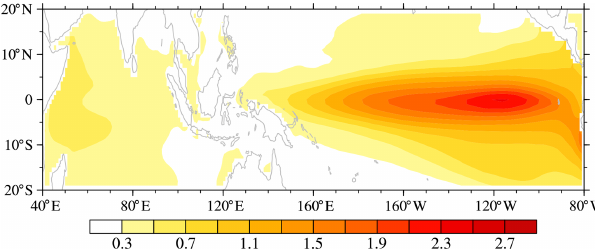
Figure 5. The standard deviations of the simulated PIOAM between the 21 selected CMIP5 models (unit: ◦